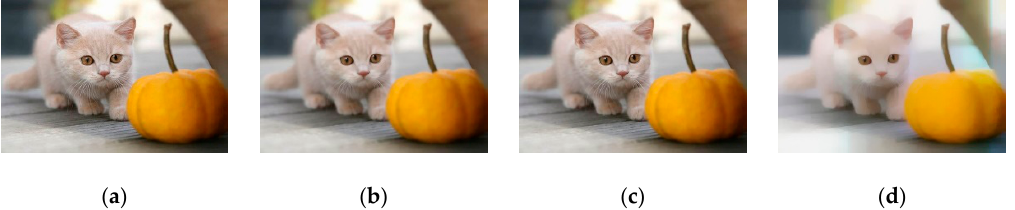
Figure 8. The comparison results of different filters. ( a ) The original image. ( b ) After guided filtering.